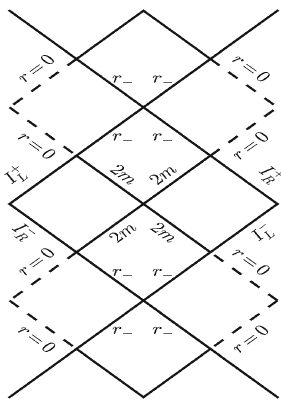
Fig. 1 Carter–Penrose diagram for the LQBH metric. The diagram has two asymptotic regions, one at infinity and the other near the origin, which no observer can reach in a finite